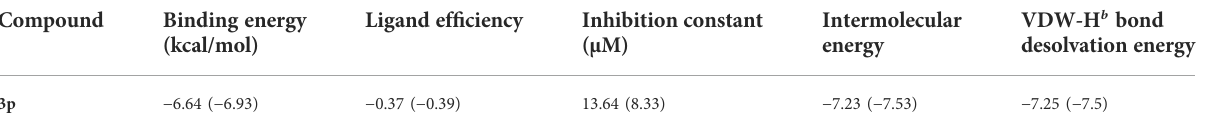
TABLE 3 Molecular docking analysis of compound 3p against the active sites of BChE a